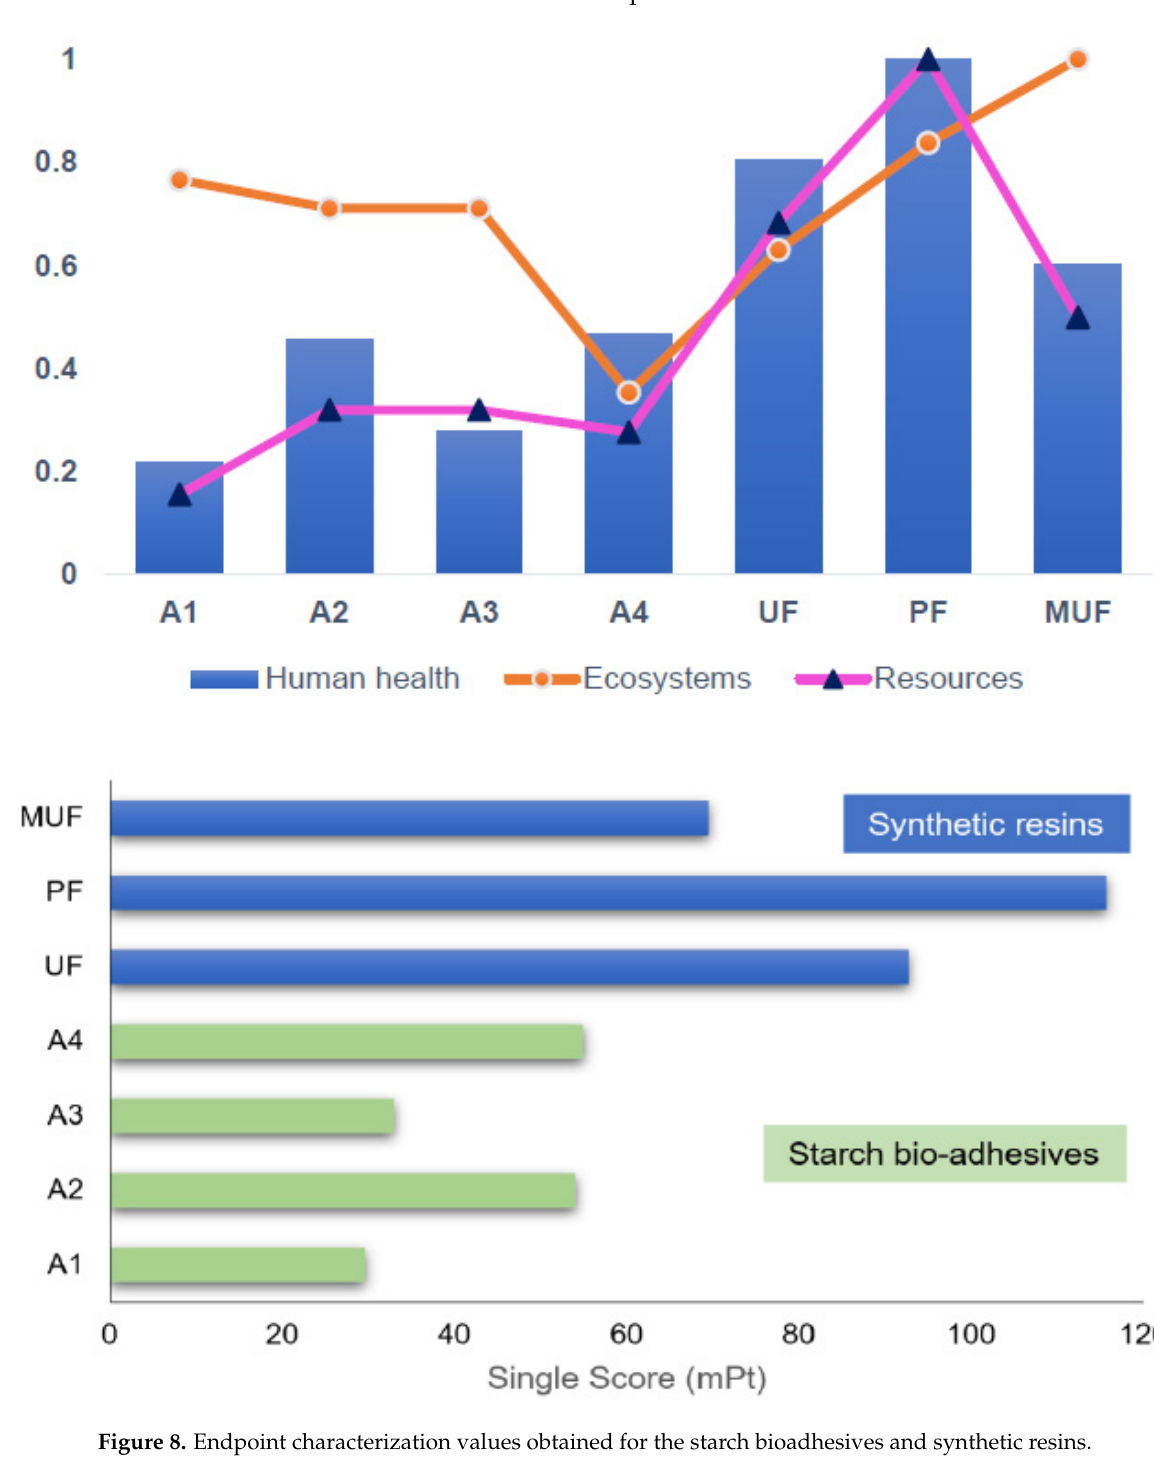
Figure 8. Endpoint characterization values obtained for the starch bioadhesives and synthetic resins.